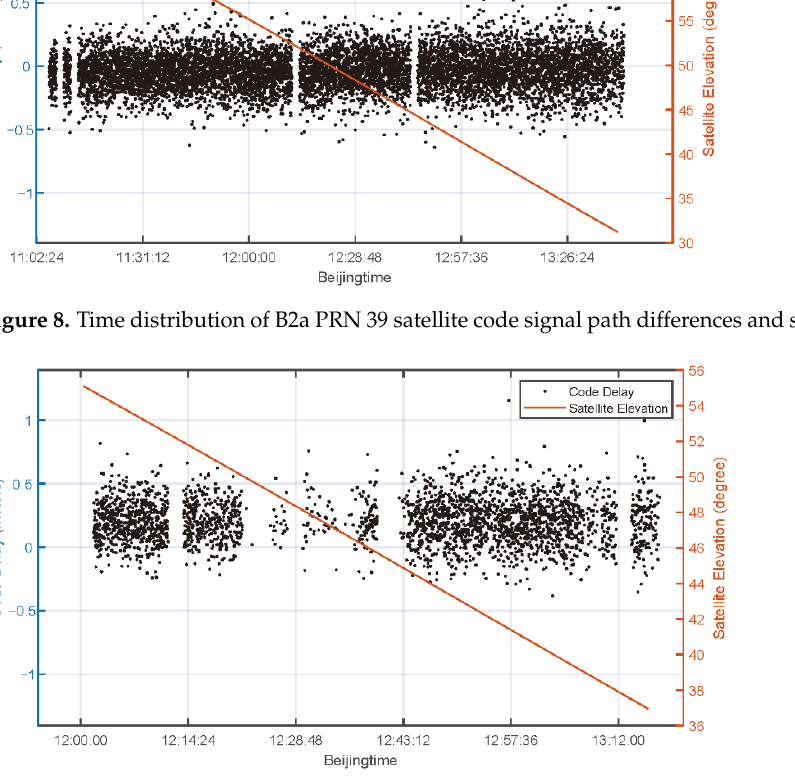
Figure 9. Time distribution of B1C PRN 39 satellite code signal path differences and satellite elevation.